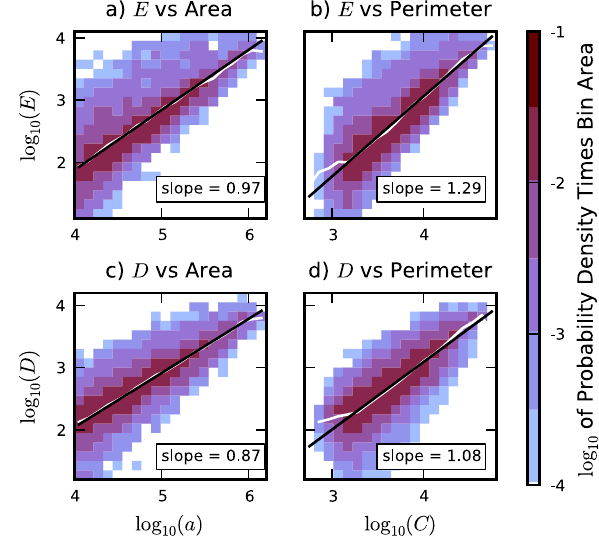
Fig. 10. Joint probability density function multiplied by bin area ( P(x,y)1x1y ) for individual clouds in the combined BOMEX and ARM LES output of log 10 (E) versus (a) log 10 of cross- sectional area, (b) log 10 of cloud core perimeter, and log 10 (D) versus (c) log 10 of cross-sectional area, (d) log 10 of cloud core perimeter. PDFs are plotted using a logarithmic scale. White lines indicate the mean log 10 (E)/ log 10 (D) value as a function of the x axis variable, and black lines show linear least-square best fits of log 10 (E)/ log 10 (D) versus the x axis